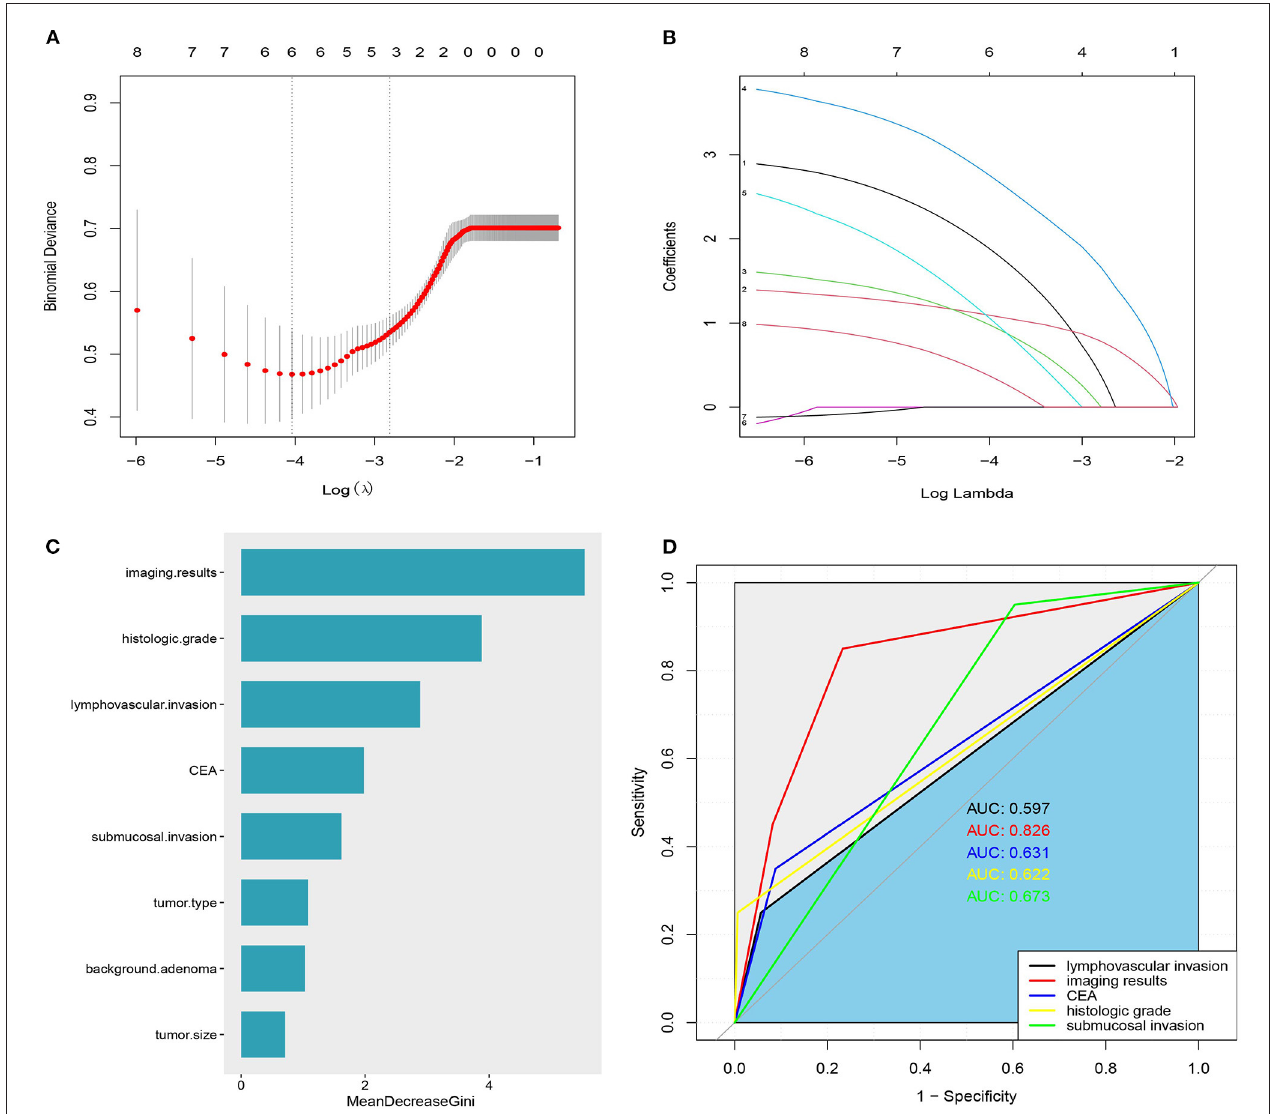
FIGURE 1 | (A) Variable selection using the least absolute shrinkage and selection operator (LASSO) regression model. (B) Lasso coefficients were shown for 8 variables: 1: Lymphovascular invasion, 2: imaging results, 3: CEA,4: Histologic grade, 5: depth of submucosal invasion, 6: tumor size, 7: adenoma background, and 8: